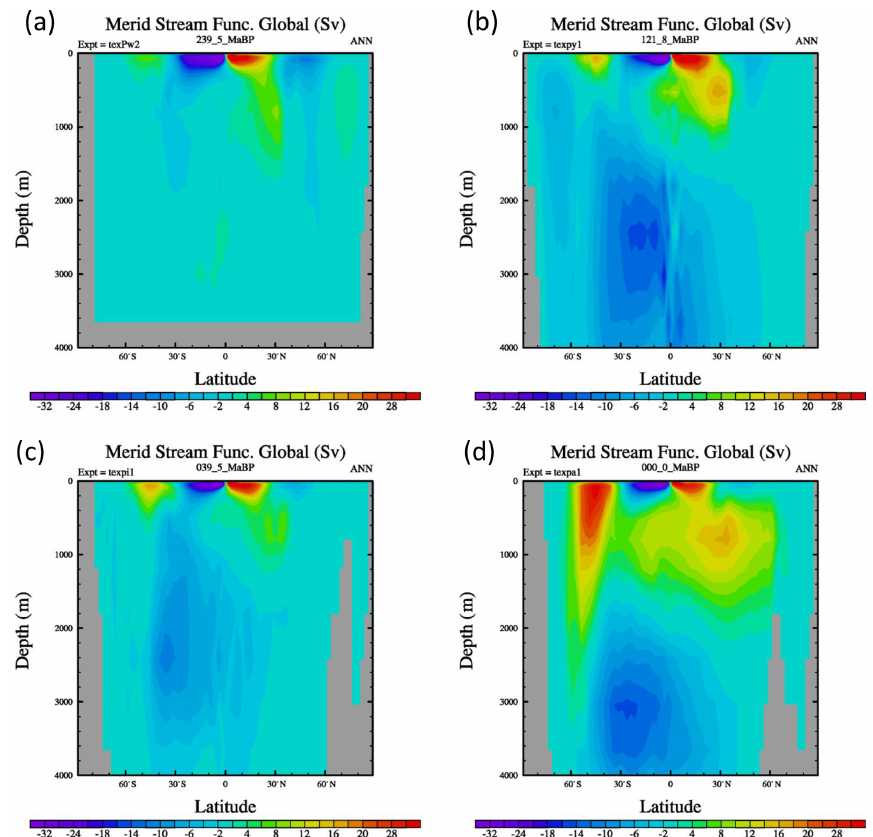
Figure 7. Global ocean overturning circulation (in Sverdrups) for four different time periods for the Foster CO 2 simulations. Positive (yel- low/red) values correspond to a clockwise circulation; negative (dark blue/purple) values represent an anti-clockwise circulation. (a) Middle Triassic, Ladinian, 239.5Ma, (b) Lower Cretaceous, Aptian, 121.8Ma, (c) Late Eocene, Bartonian, 39.5Ma, and (d) present day. Paleogeo- graphic reconstructions older than the oldest ocean floor ( ∼ Late Jurassic) have uniform deep ocean floor depth.